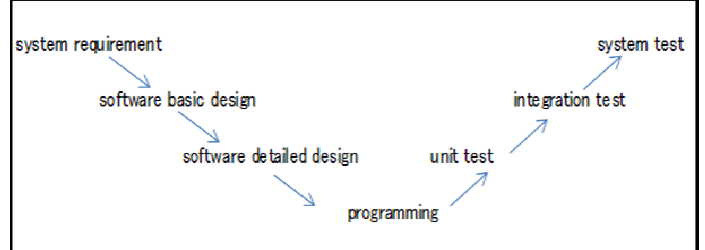
Figure 2. General Software Development